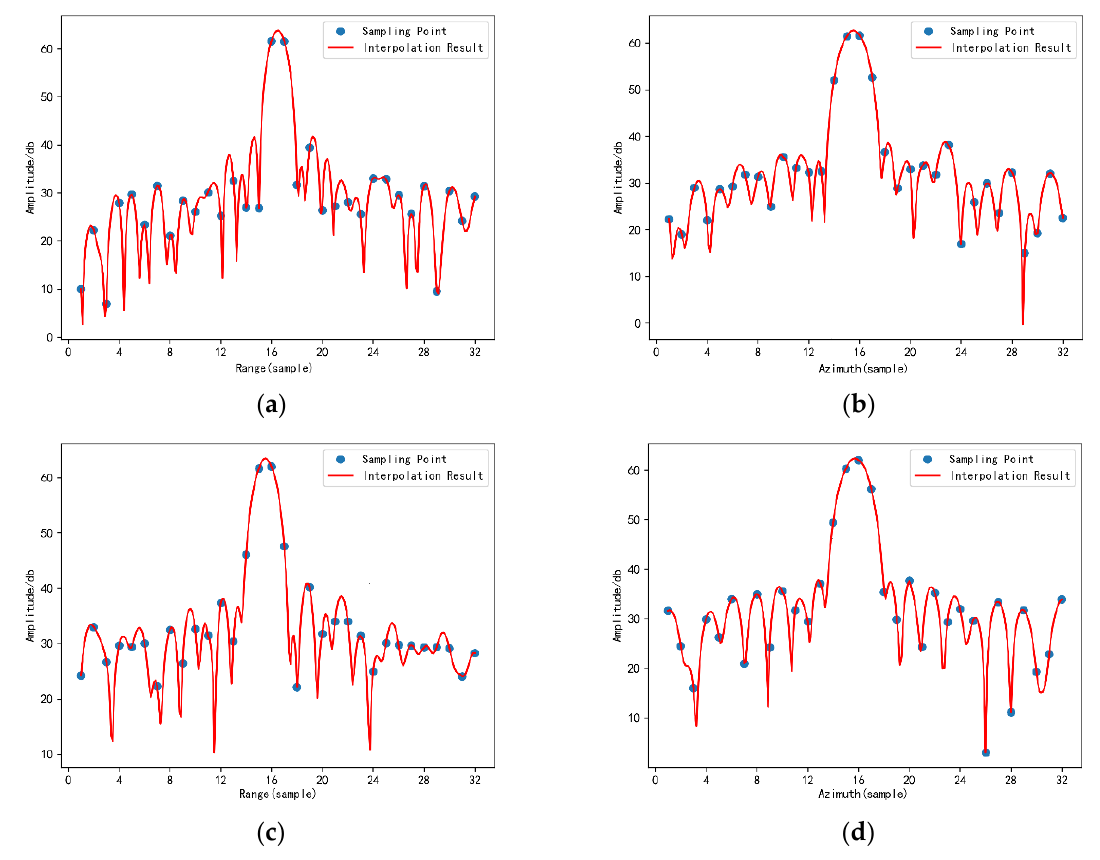
Figure 10. CR-3 one-dimensional contours of IRF in the range and azimuth directions: ( a ) range direction interpolation of UFS mode data on 12 May; ( b ) azimuth direction interpolation of UFS mode data on 12 May; ( c ) range direction interpolation of FSI mode data on 15 May; ( d ) azimuth direction interpolation of FSI mode data on 15 May.